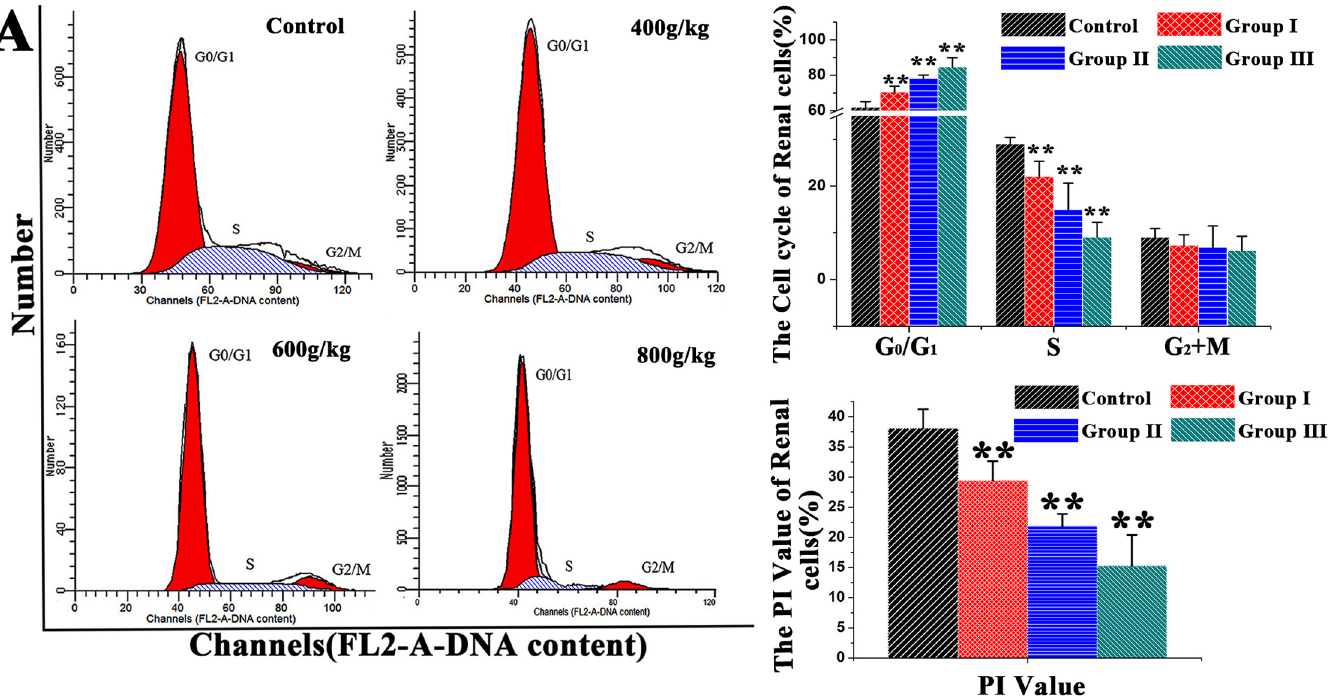
Fig 1. DNA histogram of renal cell cycle in control. (A) The Saanengoat was treated with different dose of E . adenophorum for 3 months, Then DNA histogram of renal cells cell cycle was analyzed by flow cytometry for PI staining. the G0/G1%,S% and G2+M% phases ofthe renal cells were analyzed using flow cytometry. Flow cytometric histograms are representative of 3 separate experiments. Proliferating index(PI) value = [S+(G 2 +M)]/[(G0/G1)+S+(G 2 +M)]×100%. Data are presented with the means ± SD and mean values of three independent experiments. * p < 0.05 and ** p < 0.01,comparedwith the control group.